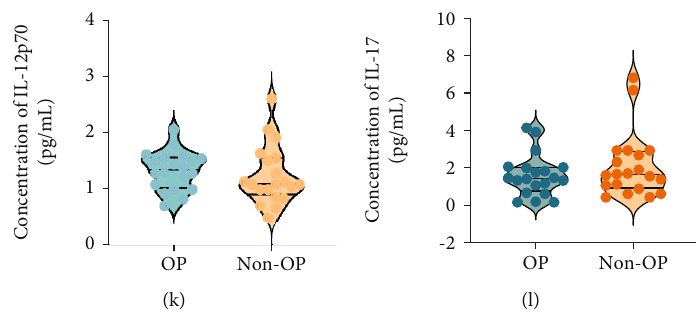
Figure 4: Comparison of the cytokines between the OP and non-OP groups. The concentration of IFN- γ (a), TNF- α (b), IFN- α (c), IL-1 β (d), IL-2 (e), IL-4 (f), IL-5 (g), IL-6 (h), IL-8 (i), IL-10 (j), IL-12P70 (k), and IL-17 (l) between the OP ( n = 20 ) and non-OP ( n = 20 ) groups was analyzed with unpaired t -test or nonparametric test (Mann-Whitney U test) according to the normality. Continuous variables in the normal distribution of the two groups were expressed as mean ± standard deviation ( mean ± SD ) and analyzed with the unpaired t -test. Continuous variables in the abnormal distribution were expressed as quartiles (50% (25%-75%)) and analyzed by the Mann-Whitney U test. P value < 0.05 was considered a signi fi cant di ff